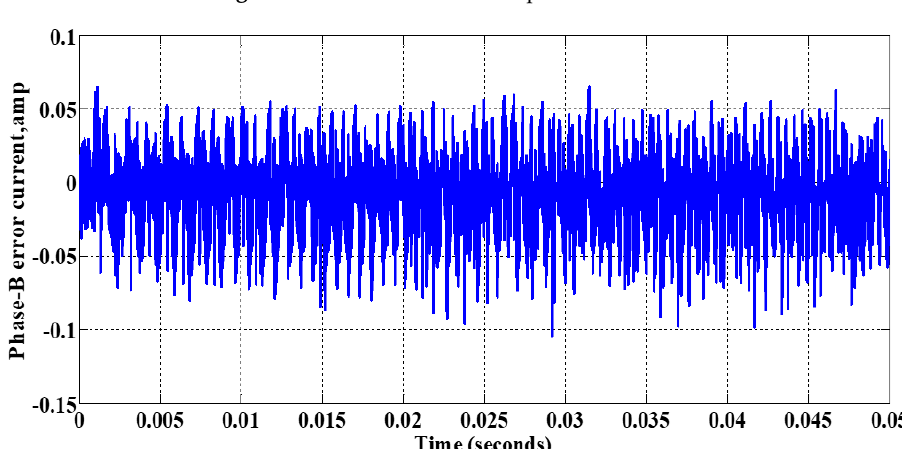
Figure 7. Estimated and actual phase-B currents.